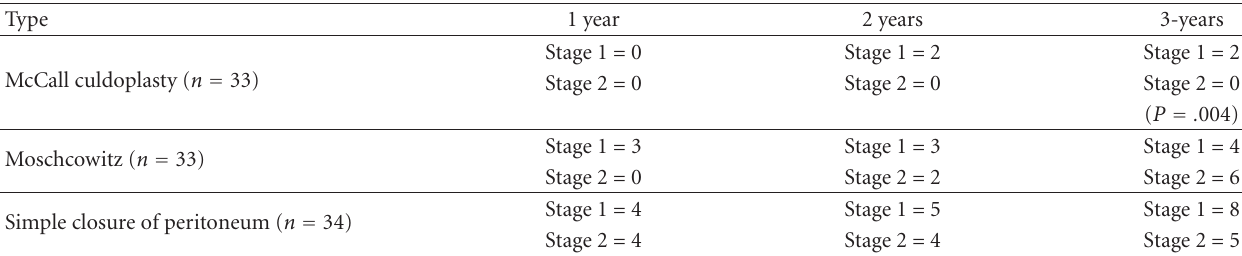
Table 2: Incidence and stages of enterocoele at follow-up